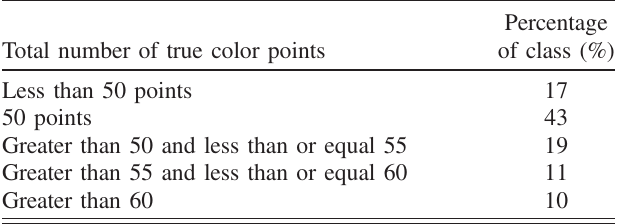
TABLE XIV. Student total color points Fall 2016 PHY